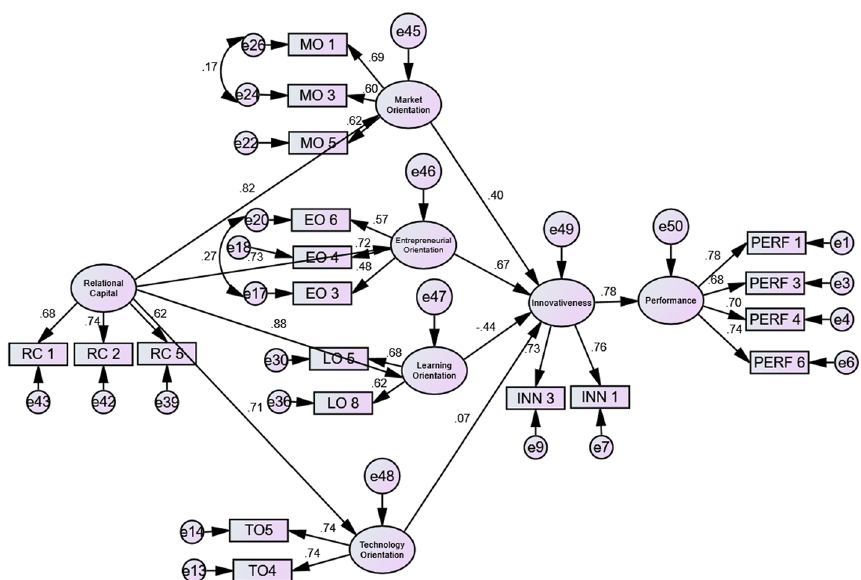
Fig. 3 The proposed model to SEM. Source: